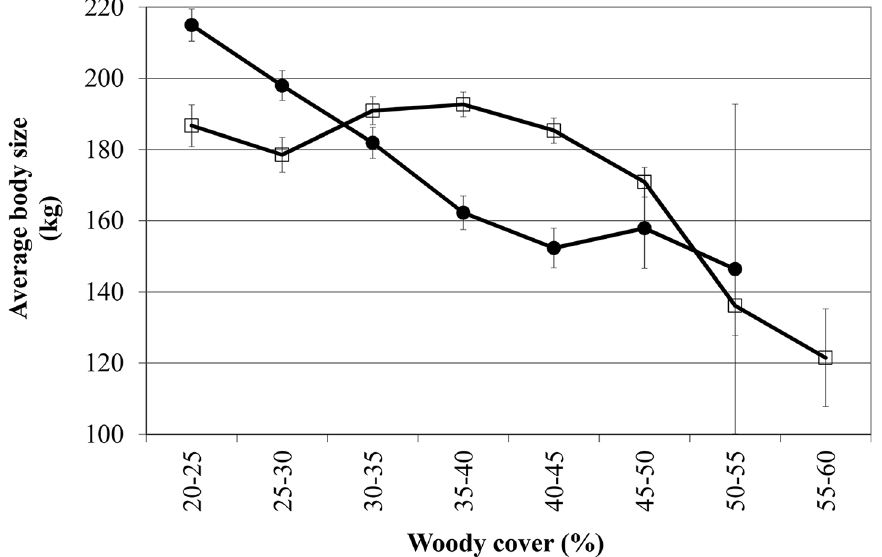
Fig 5. Average body size of herbivores along a woody cover gradient. (basalts: solid circles; granites: open squares) (standard error bars included). Note how with increasing woody cover the average body size decrease, with negative slope coefficients (basalt: -2.94071 (p < 0.0001; n = 3570); granite: -1.20524 (p < 0.0001; n =